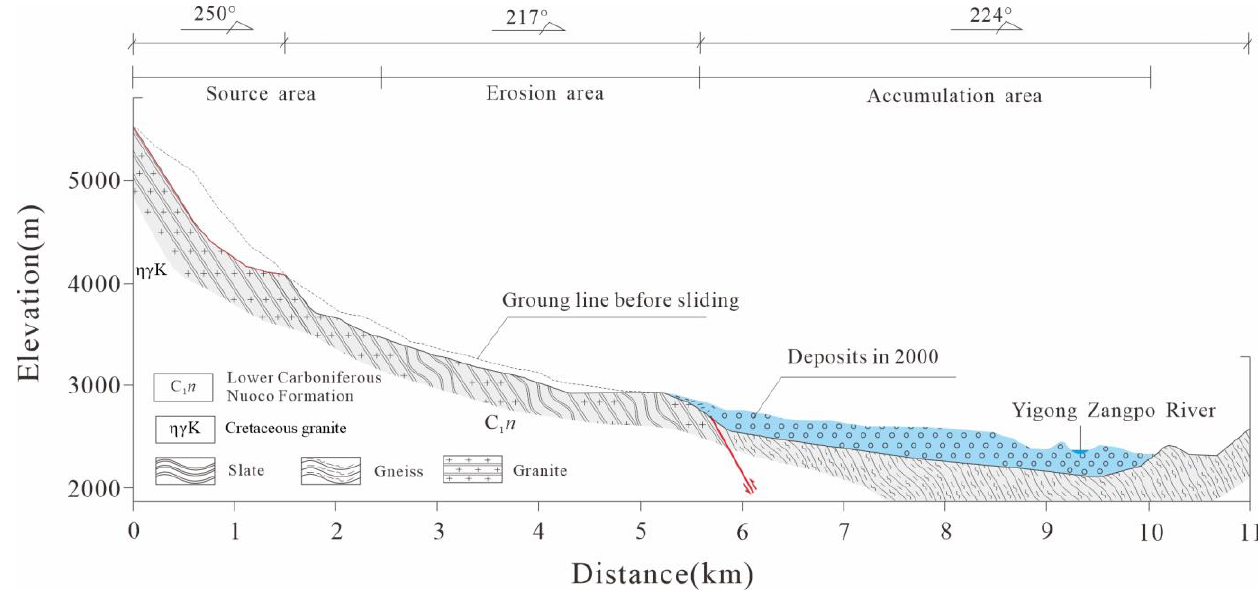
Figure 5. Geological profile of the Yigong landslide.